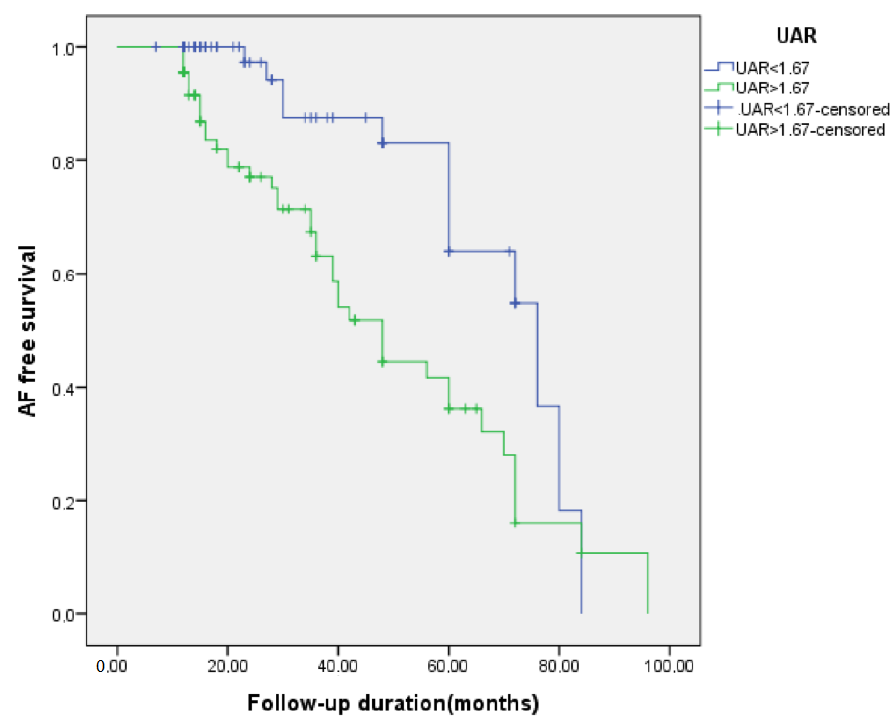
Figure 3. Kaplan-Meier curves comparing the AF free survival rate between patients with uric acid/albumin ratio (UAR) < 1.67 and UAR > 1.67.